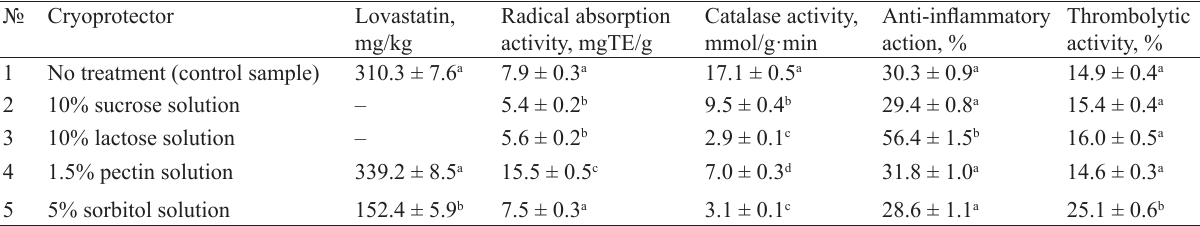
Table 3 Effect of pre-treatment with cryoprotectors on the bioactive properties of freeze-dried product (M ± m) № Cryoprotector Lovastatin,